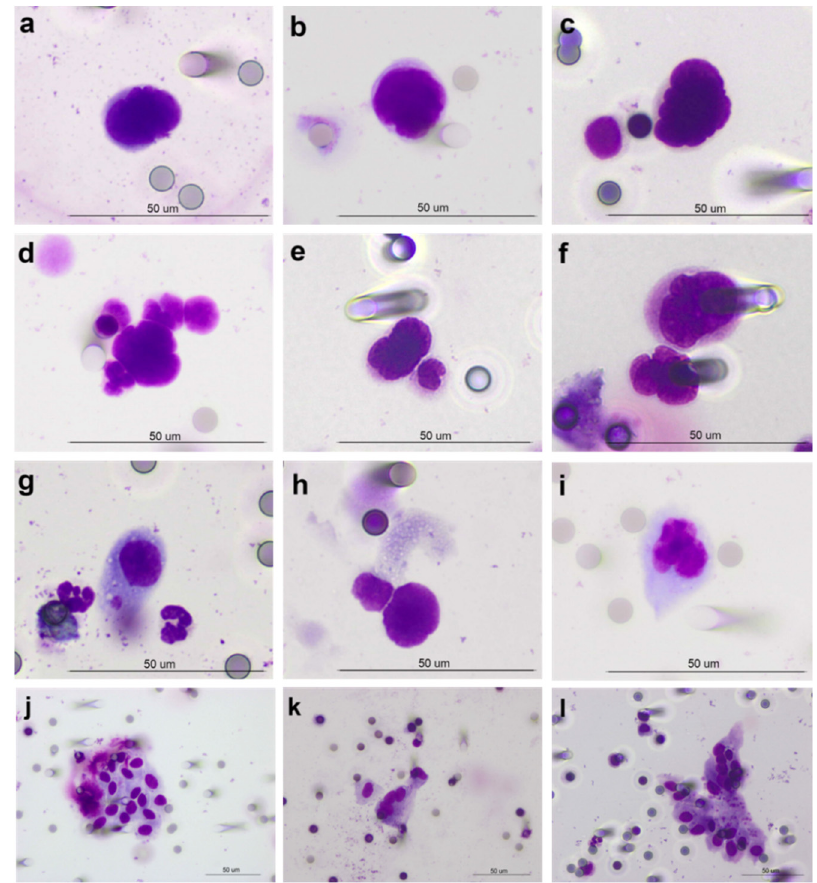
Figure 1. Subpopulations of atypical circulating cells differentiate patients with operable non-small cell lung cancer from lung cancer-free individuals. Images depict ( a – c ) single cells with morphological features of malignancy and ( d – f ) heterotypic clusters of cells with features of malignancy physically interacting with normal cells, such as ( d ) neutrophil granulocytes, ( e ) monocytes or ( f ) other indeterminate leukocytes, detected in patients, ( g – i ) atypical macrophage-like cells, ( g ) oblong or ( h ) tadpole-like, both detected in patients, and ( i ) irregularly shaped, detected in healthy donors, and ( j – l ) clusters of epithelial-like cells, detected in patients, on porous membranes stained with May–Grünwald and Giemsa. Objective magnification 40×.